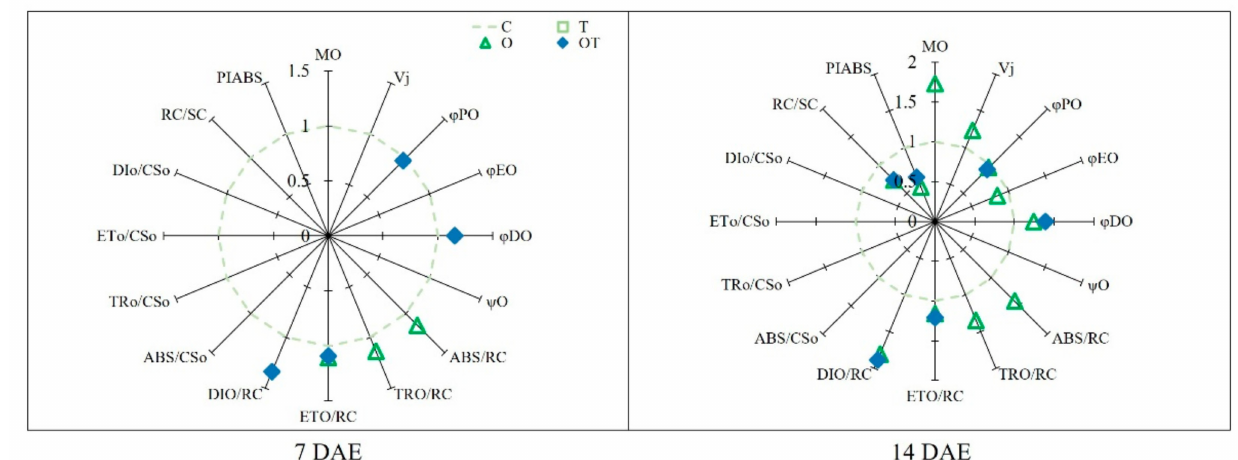
Figure 6. Spider plots of JIP parameters derived from chlorophyll a fluorescence OJIP transient curves of Brassica juncea L (see Table S1 for definitions) under different ambient and supraoptimal temperatures and O 3 concentrations at 7 and 14 DAE. The parameters values of plants grown under control conditions were set to 1. Only parameter values that were significantly different from those under C conditions at p < 0.05 according to Tukey’s honestly significant difference test are shown in the figure. C: ambient O 3 + optimal temperature; T: ambient O 3 + supraoptimal temperature; O: elevated O 3 + optimal temperature; OT: elevated O 3 + supraoptimal temperature; DAE: days after the beginning of